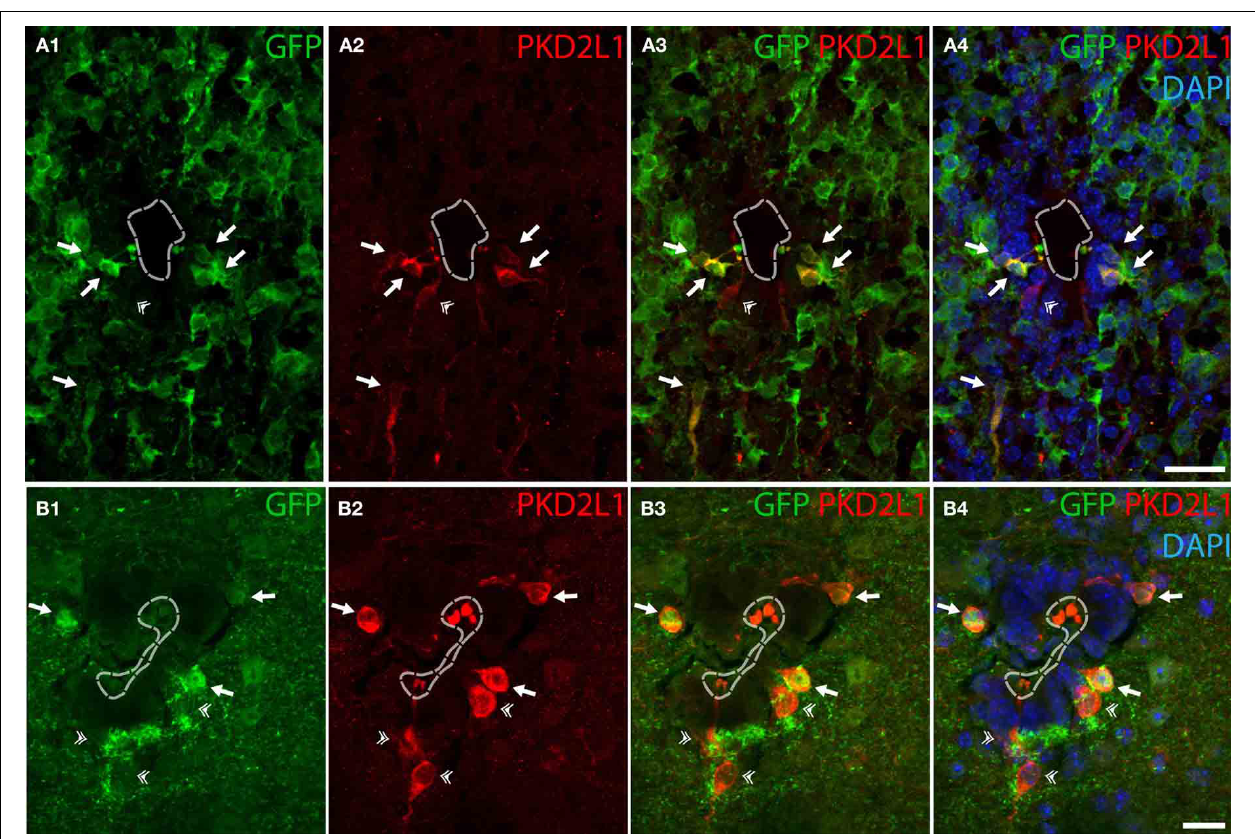
FIGURE 2 | Some PKD2L1 + cells surrounding the central canal of cervical spinal cord of adult mouse are immunoreactive for GFP in the knock-in GAD67-GFP mouse. (A) 10 μ m-thick coronal sections of GAD67-GFP E16.5 mouse spinal cord immunostained for GFP (A1,A3,A4) and PKD2L1 (A2–A4) . Most PKD2L1 + cells are GFP + (arrows) but not all